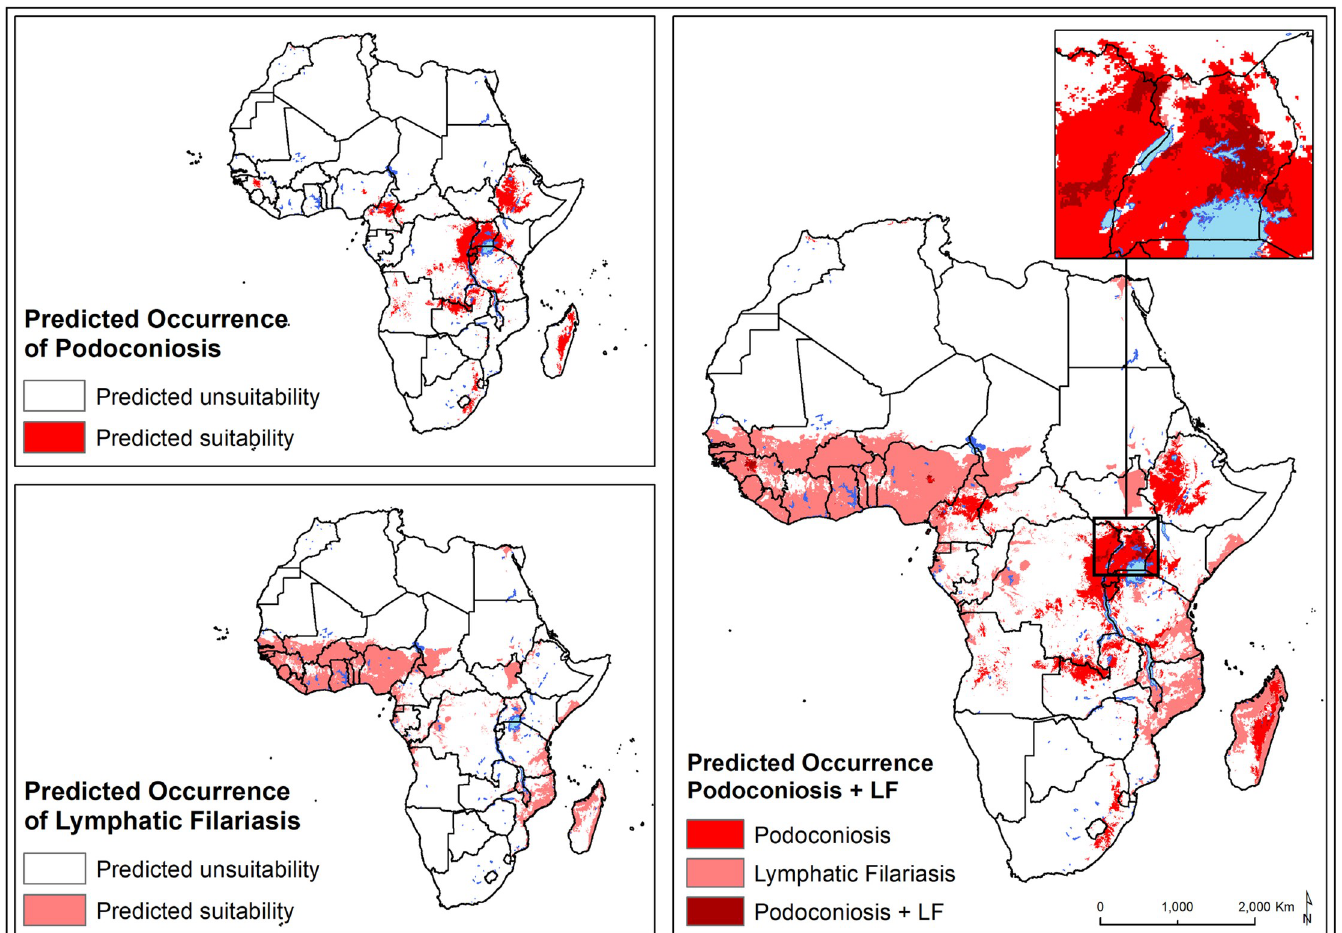
Fig 4. Predicted occurrence of podoconiosis and lymphatic filariasis in Africa. Environmental suitability for lymphatic filariasis according to the predictive map published by Cano et al. (2014) [56].